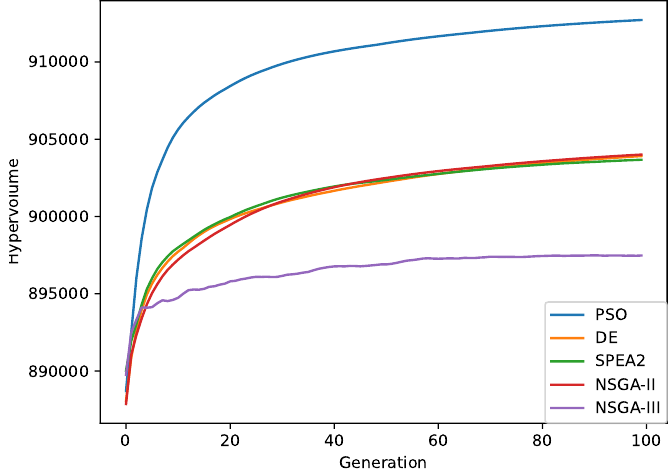
Figure 9. Averaged hypervolume metric over 100 generations for all multi-objective optimisation